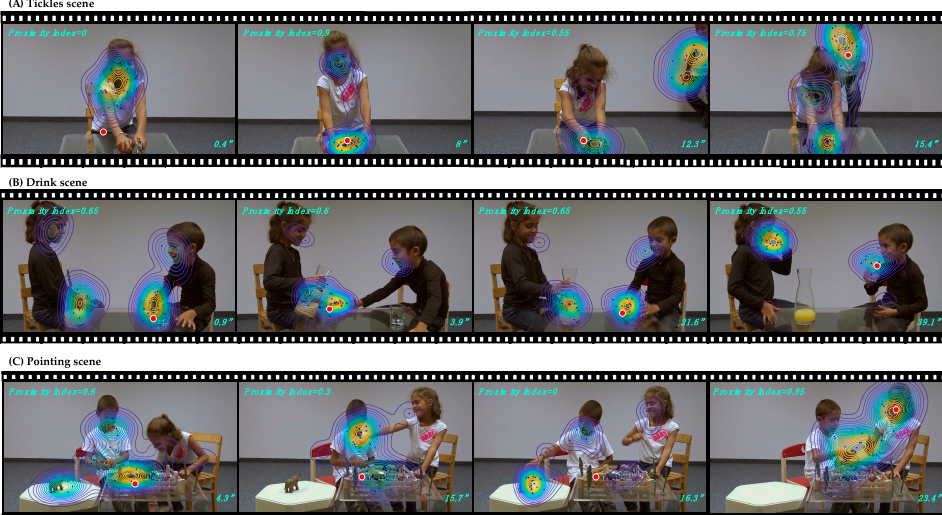
Figure 1. Illustration of the data-driven eye-tracking method. Normative gaze data distribution (“norm”), delimited by contours, was created using gaze coordinates from 36 typically developing children (aged 3.9 ± 0.7). For each TD child, the exact gaze position on a given frame is indicated using blue dots. The three rows show screenshots extracted from the three different social scenes, depicting the norm (colored contours) and gaze data from a 4.5 years old male with ASD (red circle). Proximity values with regards to the norm were obtained on each frame and are indicated in the upper left corner of the given frames. A timestamp for each frame is depicted in the lower right corner.